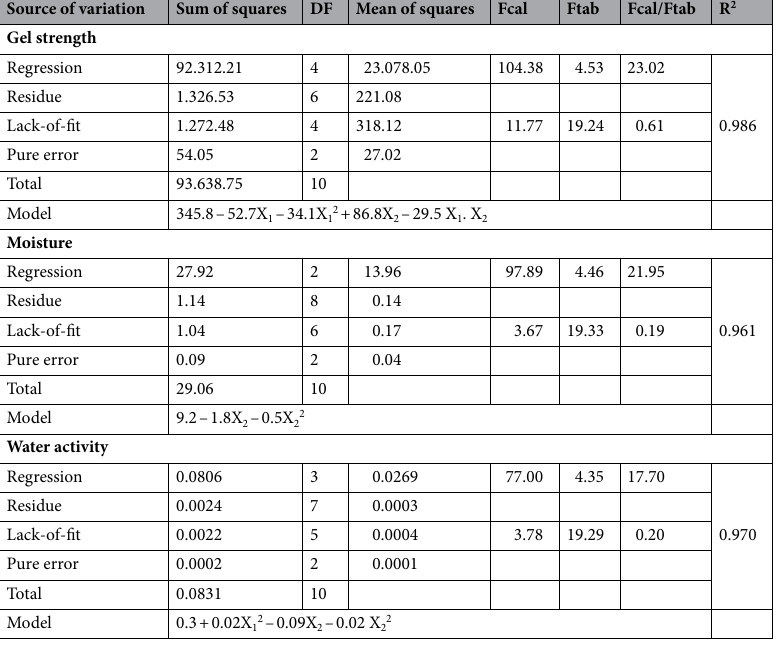
Table 4. Analysis of variance and model of gel strength, moisture, and water activity of the independent variables, F test, and R 2 . Fcal: calculated F; Ftab: tabulated F; DF: Degrees of freedom. X 1 : Linear time; X 1 2 : Quadratic time; X 2 : Linear temperature; X 2 2 : Quadratic